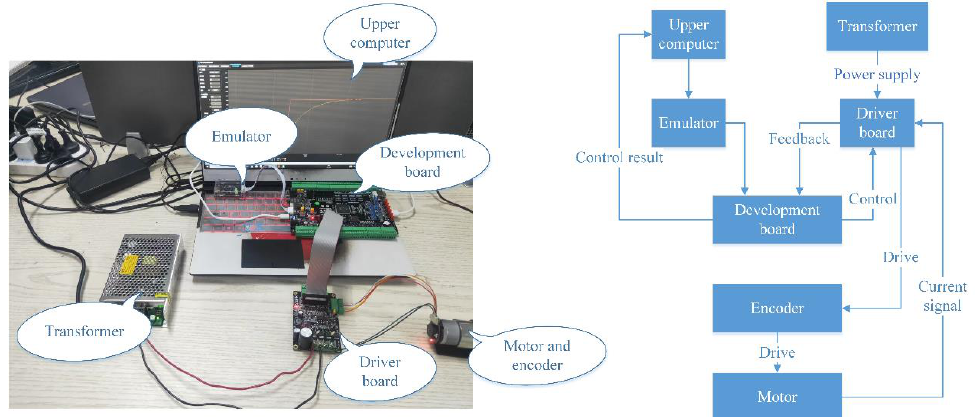
Figure 10. Control circuit test bench and test procedure.